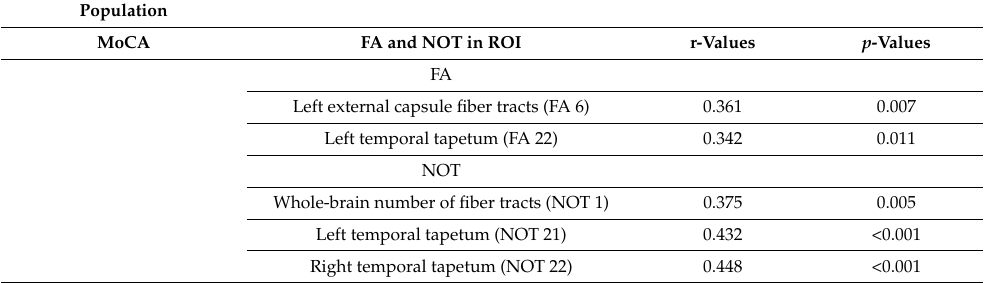
Table 4. Significant correlations between MoCA scores and WM tractographic properties overall.